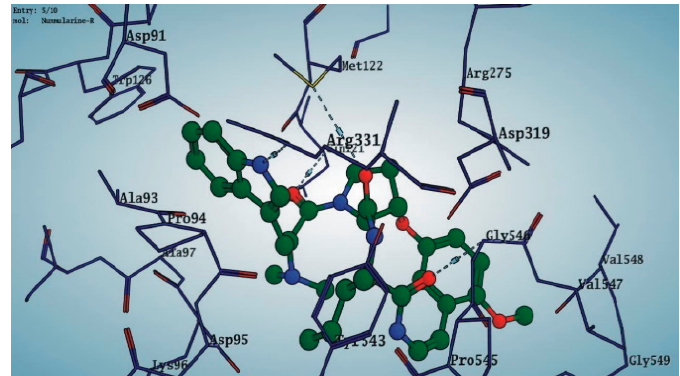
Figure 7. 3D interaction of most active compound 14 (Nummularine-R).